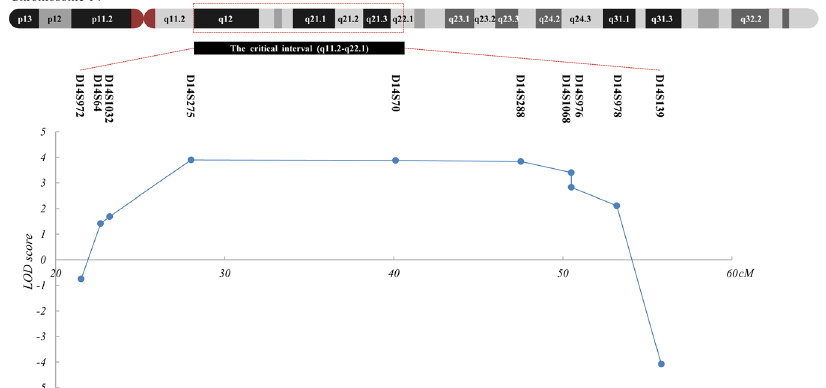
Figure 4. Assignment of the locus for CACD to chromosomal region 14q12-q22.1. Relative order of genotyped microsatellite markers are shown at the bottom next to an ideogram of chromosome 14. Results from multipoint linkage analysis and genetic locations for the markers genotyped are shown